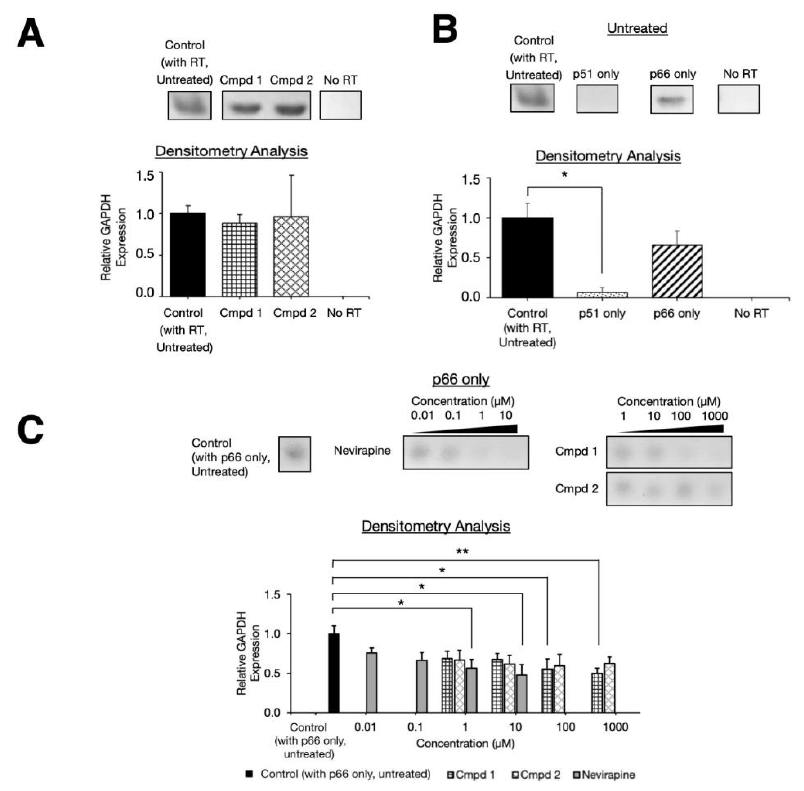
Figure 4. Inhibition analysis of individual RT subunits p66 and p51 by the identified compounds. ( A )